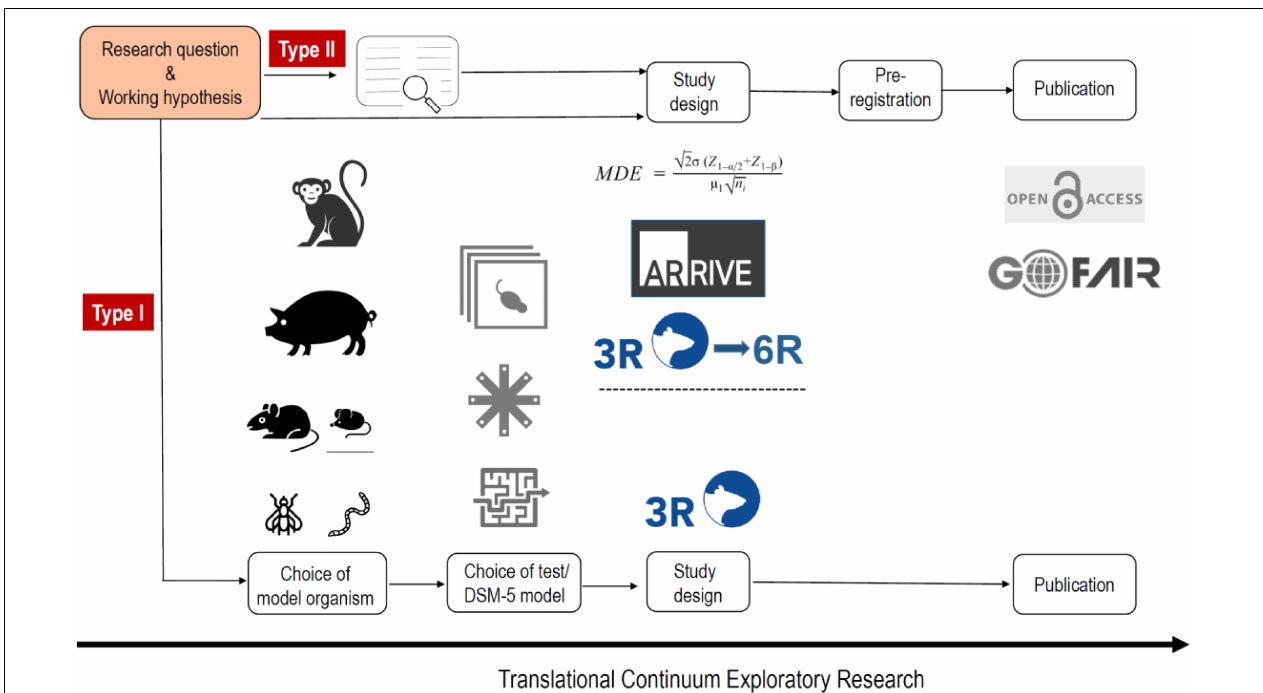
FIGURE 1 | The workflow of an exploratory animal study type I and II. In the case of an exploratory study Type I, in which methodological new ground is broken the choice of model organism is of critical importance as well as the choice of behavioral test (which could be also a DSM-5-based behavioral model). The study design should be in accordance with the 3R principles, however, registration of the study design makes no sense, since experimental parameters are likely to be modified again and again in the course of the study until the new approach ultimately measures what is intended and can then be published. For a type II study the method is already established in a laboratory and is used to carry out new measurements. The study design can involve a power calculation (based on a systematic review), and is in accordance with the ARRIVE 2.0 guidelines and the 3R/6R principles. Pre-registration should be done and the publication irrespective if it reports negative or positive results should be open access and all digital data should be handled in accordance to the FAIR